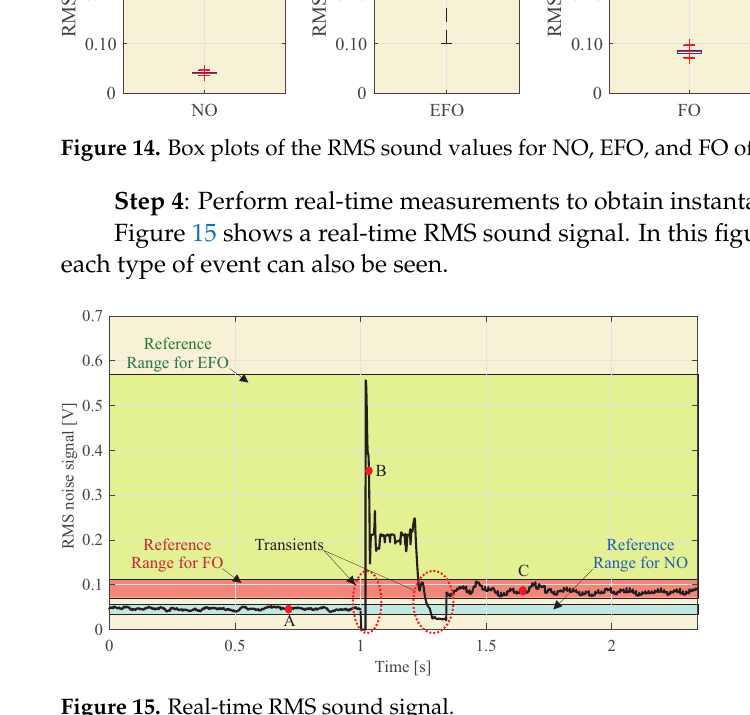
Figure 15. Real-time RMS sound